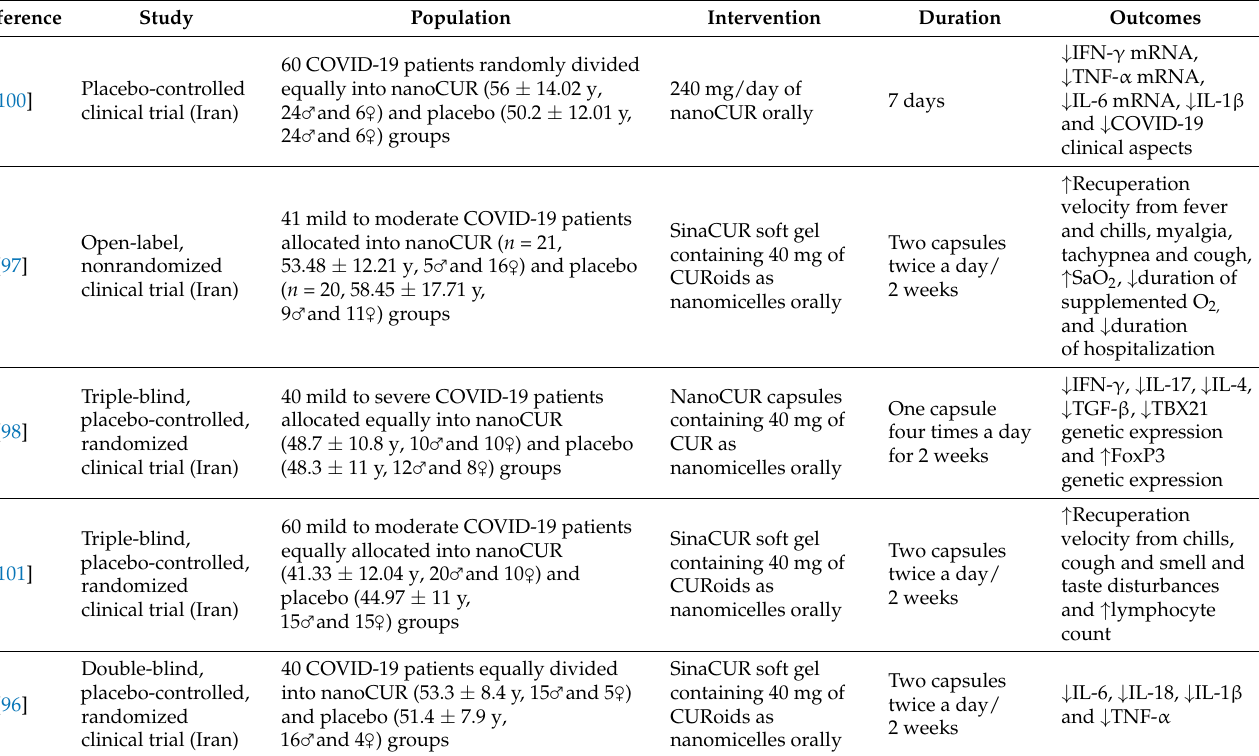
Table 2. Information of studies regarding the use of CUR-based nanomedicines in COVID-19 patients summarized following PRISMA [159]